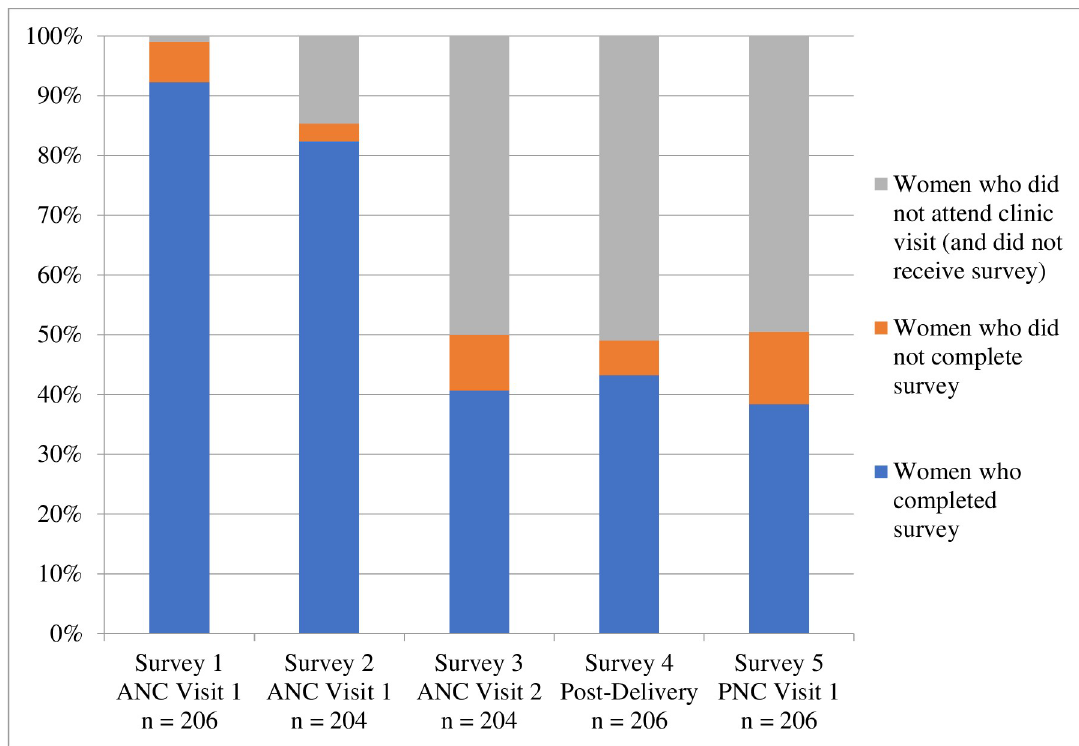
Fig 5. Survey completion. Proportion of completion by survey. Note that women who did not attend clinic may have 1) missed her appointment, 2) sought care at a non-participating clinic, or 3) visited a participating clinic, but did not receive the survey because of a technological error. Technological errors occurred when a payment from the M-TIBA wallet did not trigger a survey, but most of these instances were captured, and team members manually sent the survey, successfully collecting data from those